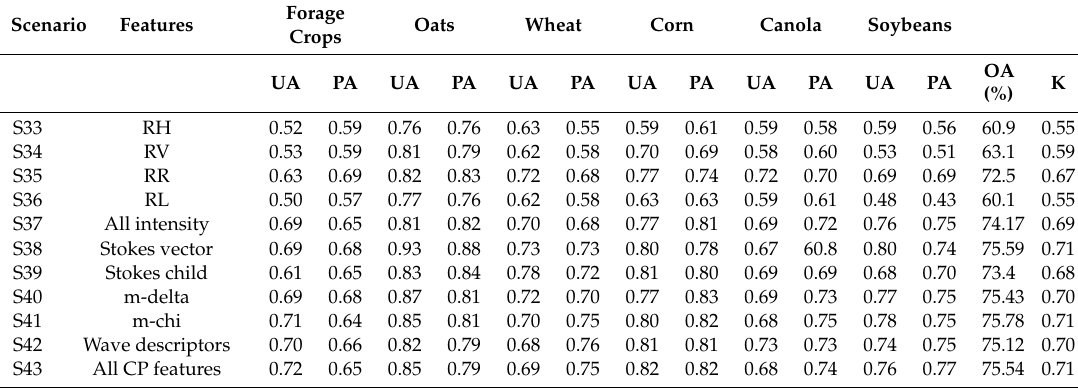
Table 8. Classification results obtained from extracted features from simulated CP SAR data at a noise floor (NF) of − 19 dB (see Table 3 for an overview of extracted features in this study).